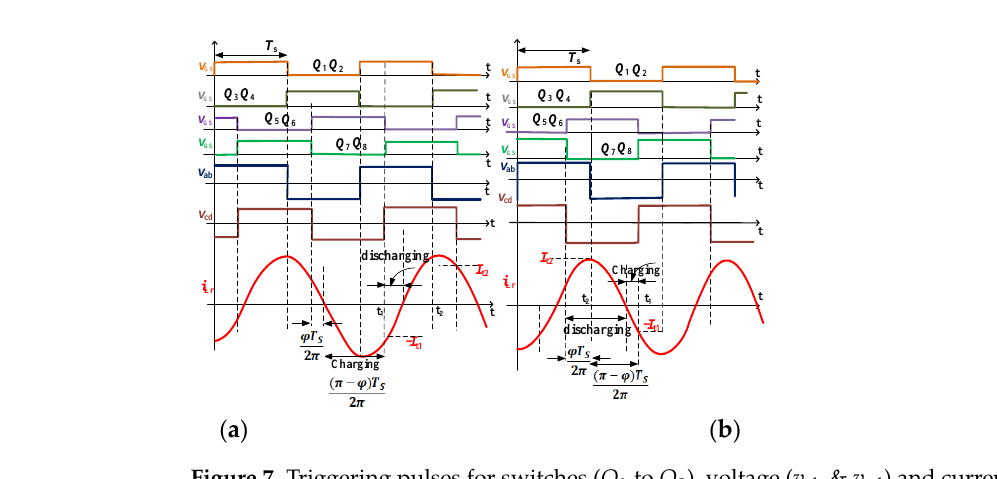
Figure 7. Triggering pulses for switches ( Q 1 to Q 8 ), voltage ( v ab & v cd ) and current ( i p or i Lr ) of the converter ( a ) Forward mode ( b ) Reverse mode.